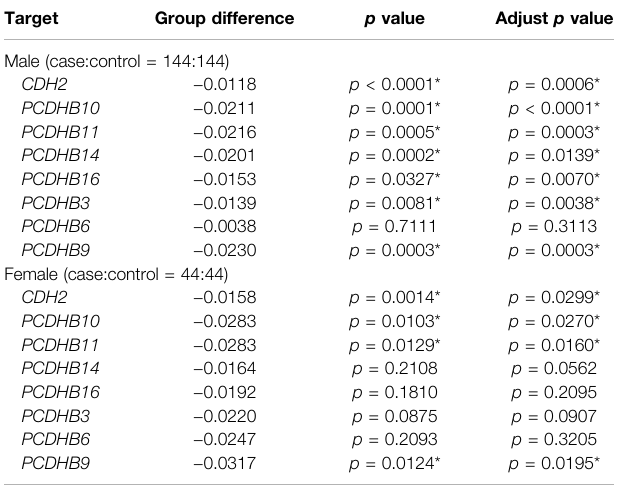
TABLE 6 | Strati fi ed analysis by ischemic stroke location. Target Group difference p value Adjust p value Anterior circulation-left hemisphere (case:control = 72:72)